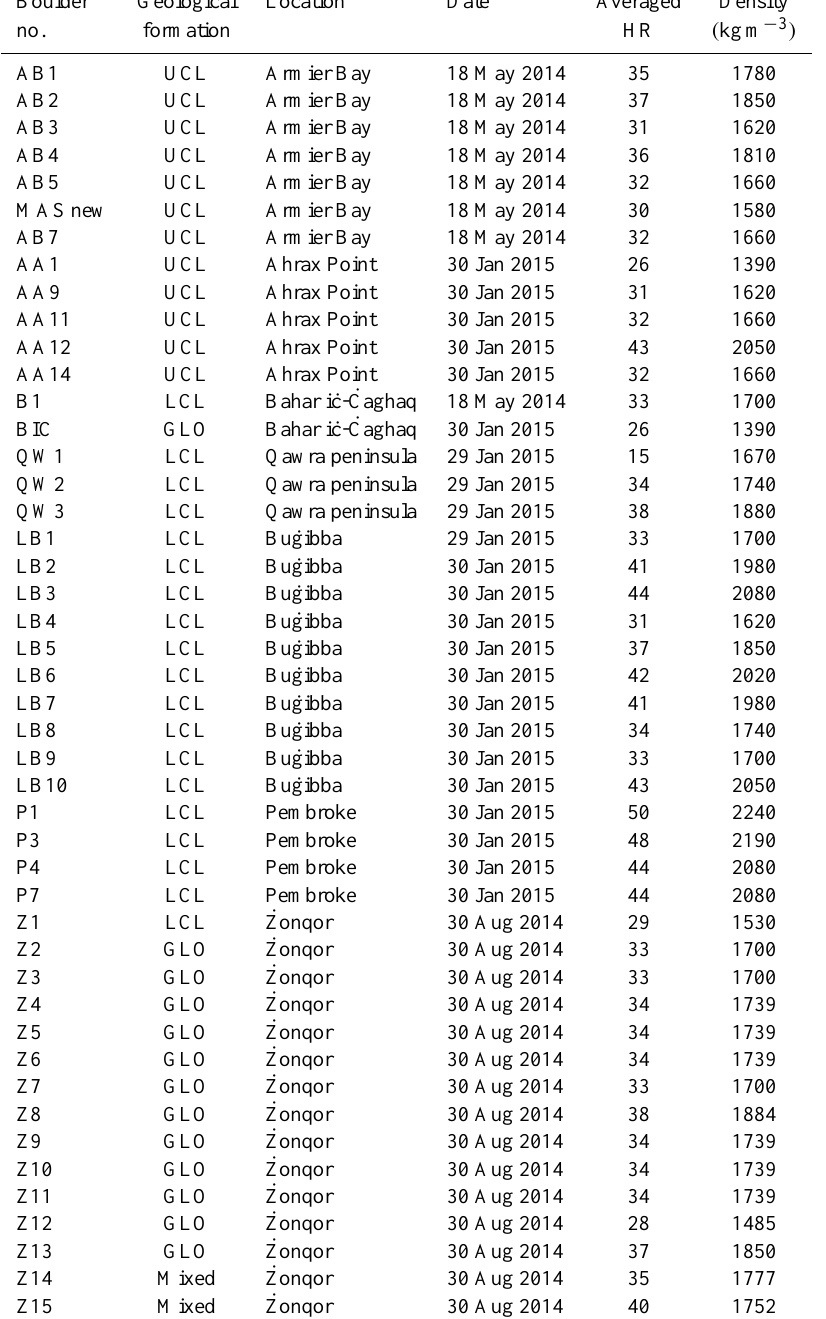
Table 2. N -type Schmidt Hammer R values performed on boulder accumulations situated along the eastern coast of Malta. The densities of boulders were determined by the formula developed by Katz et al.